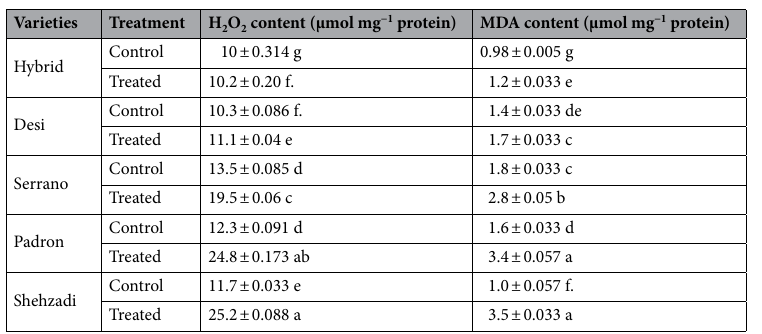
Table 2. The oxidative stress parameters values (mean ± SE) of chilli varieties against bacterial spot disease recorded after 72 h of inoculation. Values demonstrate means ± SE (n = 5). Different letters indicate a significant difference among the treatment (p < 0.05).